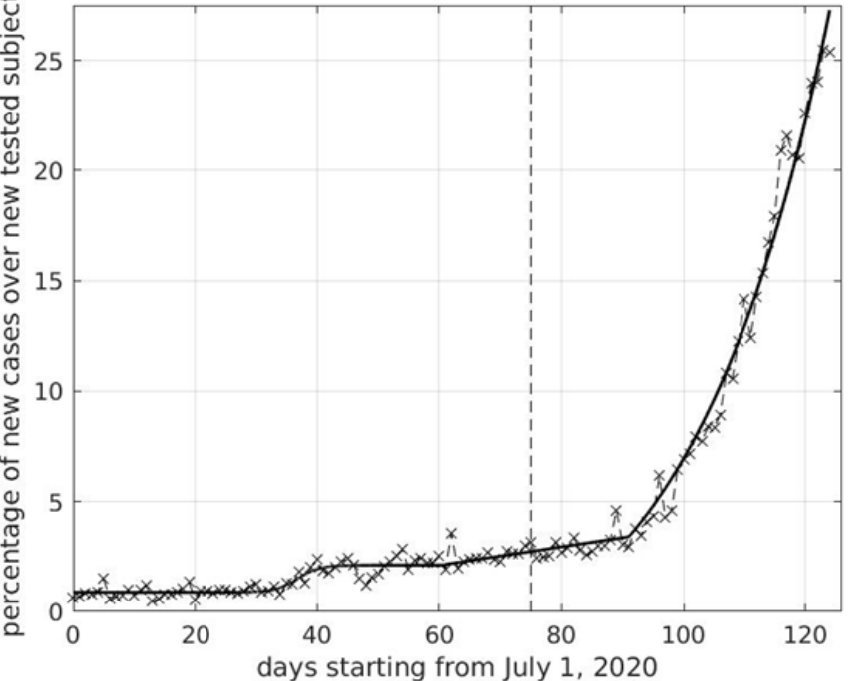
Figure 1. Percentage of SARS-Cov-2 positive cases over tested subjects in Italy versus number of days starting from July 1. The dashed vertical segment corresponds to schools re-opening on September